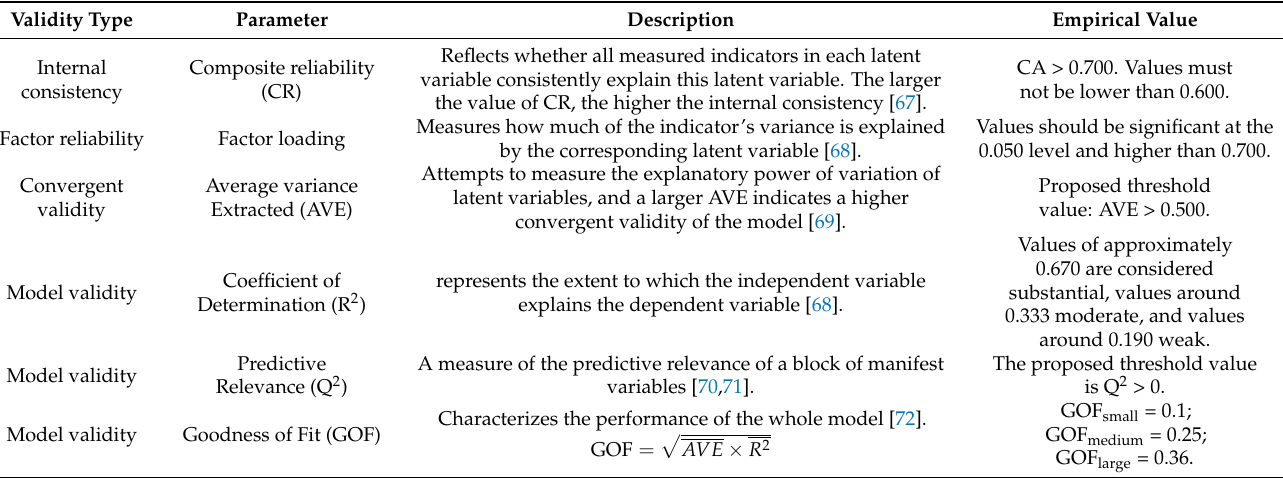
Table A1. Description of indicator